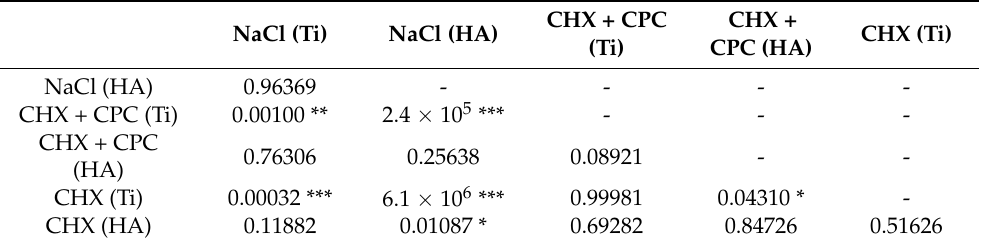
Figure 2. Bacteria viability after 48 h of in situ plaque collection and treatment with NaCl, CHX + CPC or CHX at two types of surfaces (i.e., Ti and HA). Table 2. A multiple comparison test (Nemenyi post hoc test) was performed to compare the groups after 48 h of in situ plaque